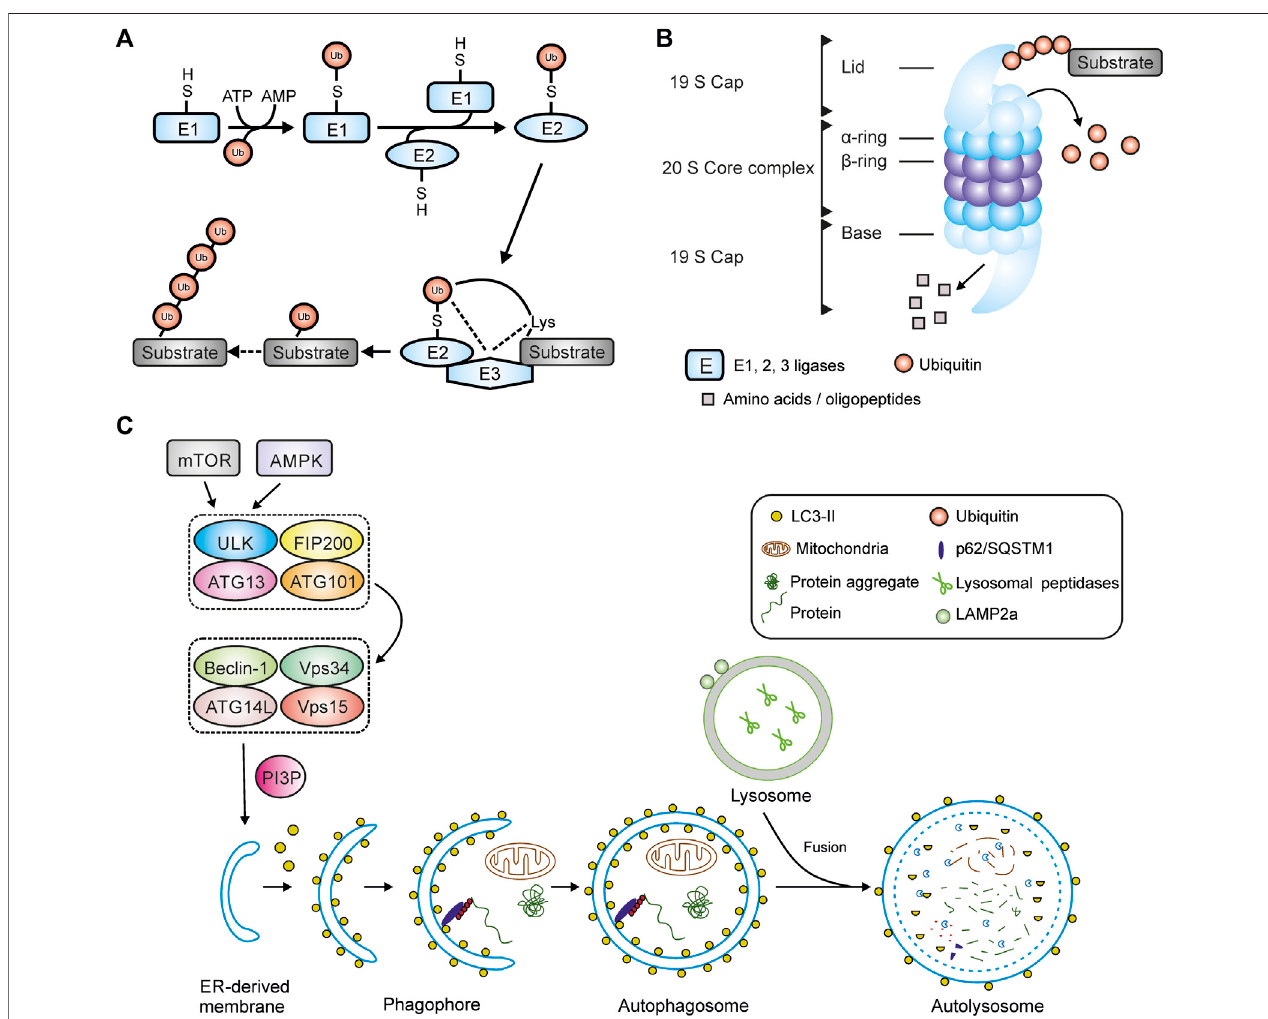
FIGURE1 | Main components ofprotein quality control. (A) Ubiquitination of asubstrate protein byE1-, E2- and E3-ligases. (B) Structure of the 26S-proteasome. (C) Schematic overview of macroautophagy including autophagy initiation complexes, autophagosome maturation and fusion with a lysosome. Abbreviations: AMPK, AMP activated protein kinase; Atg, autophagy-related (gene); FIP200, focal adhesion kinase family-interacting protein of 200 kD; LAMP2a, lysosomal-associated membrane protein 2a; LC3, microtubule-associated protein 1 light chain 3; mTOR, mammalian target of rapamycin; PI3P, phosphatidylinositol 3-phosphate; ULK1, unc-51 – like autophagy-activating kinase 1; Vps34, class III phosphoinositide 3-kinase; Vps15, serine-threonine kinase Vps15/ird1.